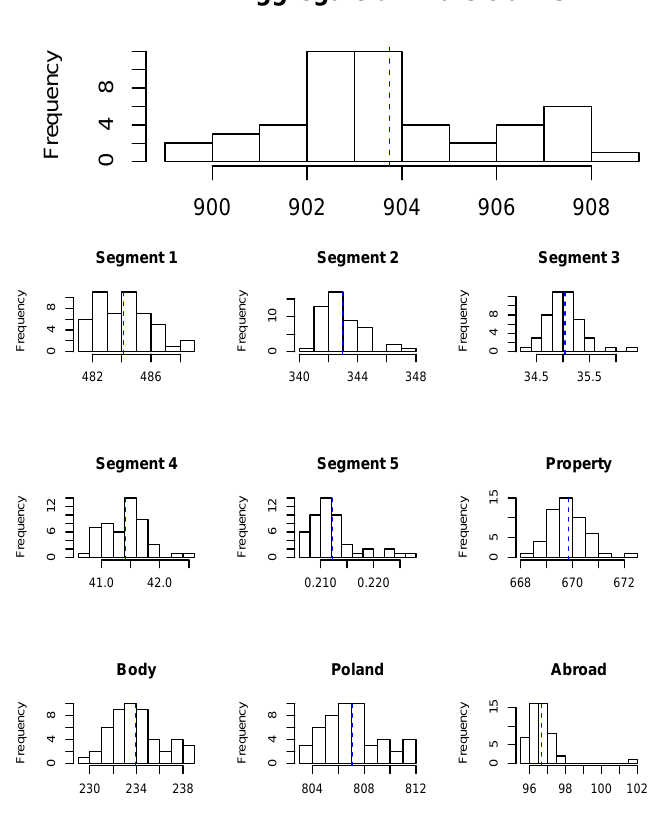
Figure 1. Histograms of the aggregate ultimate payments from the RBNS claims (in MM). The dashed lines indicate the mean value from the